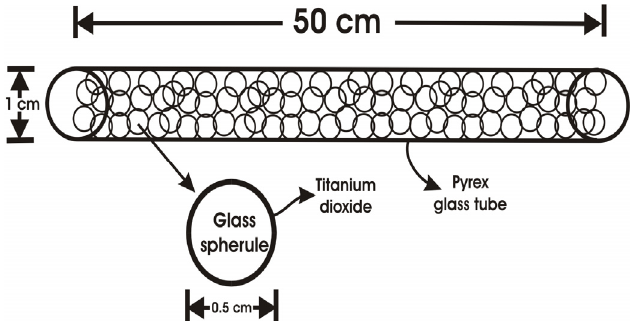
Figure 8. A photocatalytic reactor filled with silica beads coated with titania paste externally irradiated by UV irradiation